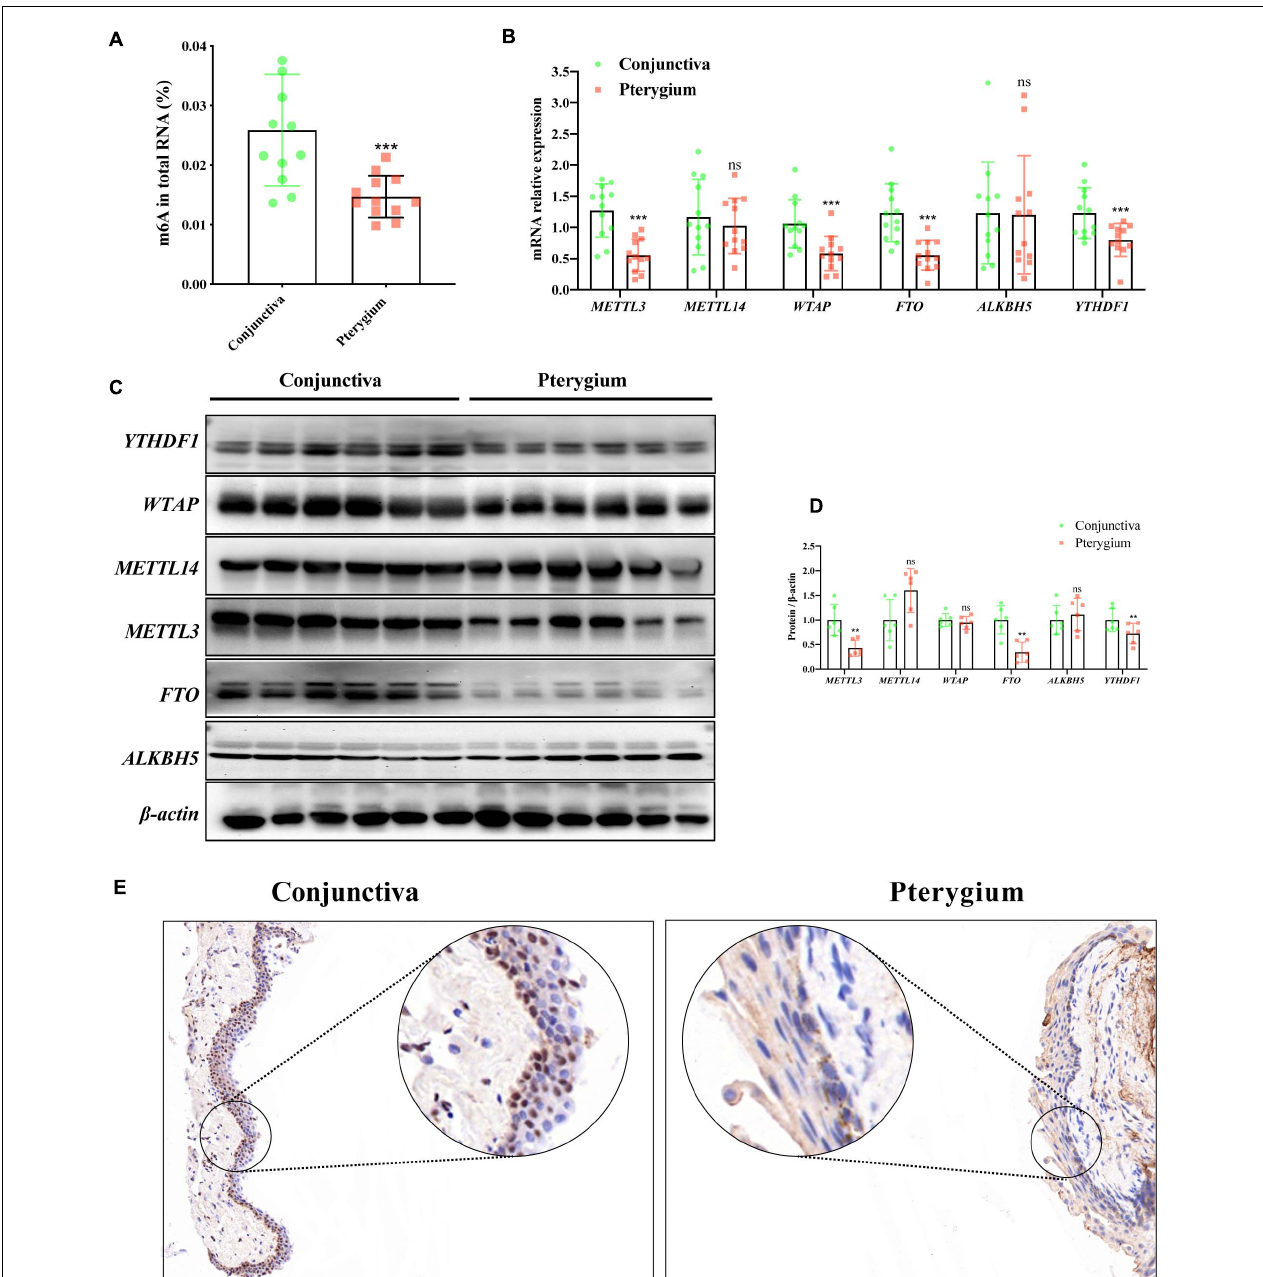
FIGURE 2 | m6A and METTL3 are downregulated in pterygium. (A) Quantification of m6A in total RNA in pterygium and conjunctiva tissues. N = 12 per group. (B) mRNA expression level of the major enzymes of m6A in pterygium and conjunctiva tissues: METTL3 , METTL14 , WTAP , FTO , ALKBH5 , YTHDF1 . N = 12 per group. (C,D) Protein expression levels of these enzymes determined via Western blotting (C,D) the results of corresponding densitometric analyses. N = 12 per group. (E) Immunohistochemistry staining of METTL3 in pterygium and conjunctiva tissues. Scale bar: 25 µ m. Results are expressed as the mean ± SEM (NS indicates not significant, ** P < 0.01, *** P < 0.001, compared to the conjunctiva group).